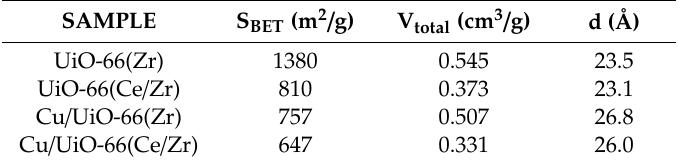
Figure 1. N 2 adsorption isotherms ( a ) and BJH adsorption pore size distribution ( b ) for UiO-66 and Cu / UiO-66 materials. In ( a ) filled symbols—adsorption, empty symbols—desorption. Table 1. Specific surface area (S BET ), total pore volume (V total ), and mean pore size (d) for UiO-66 and Cu / UiO-66 materials.